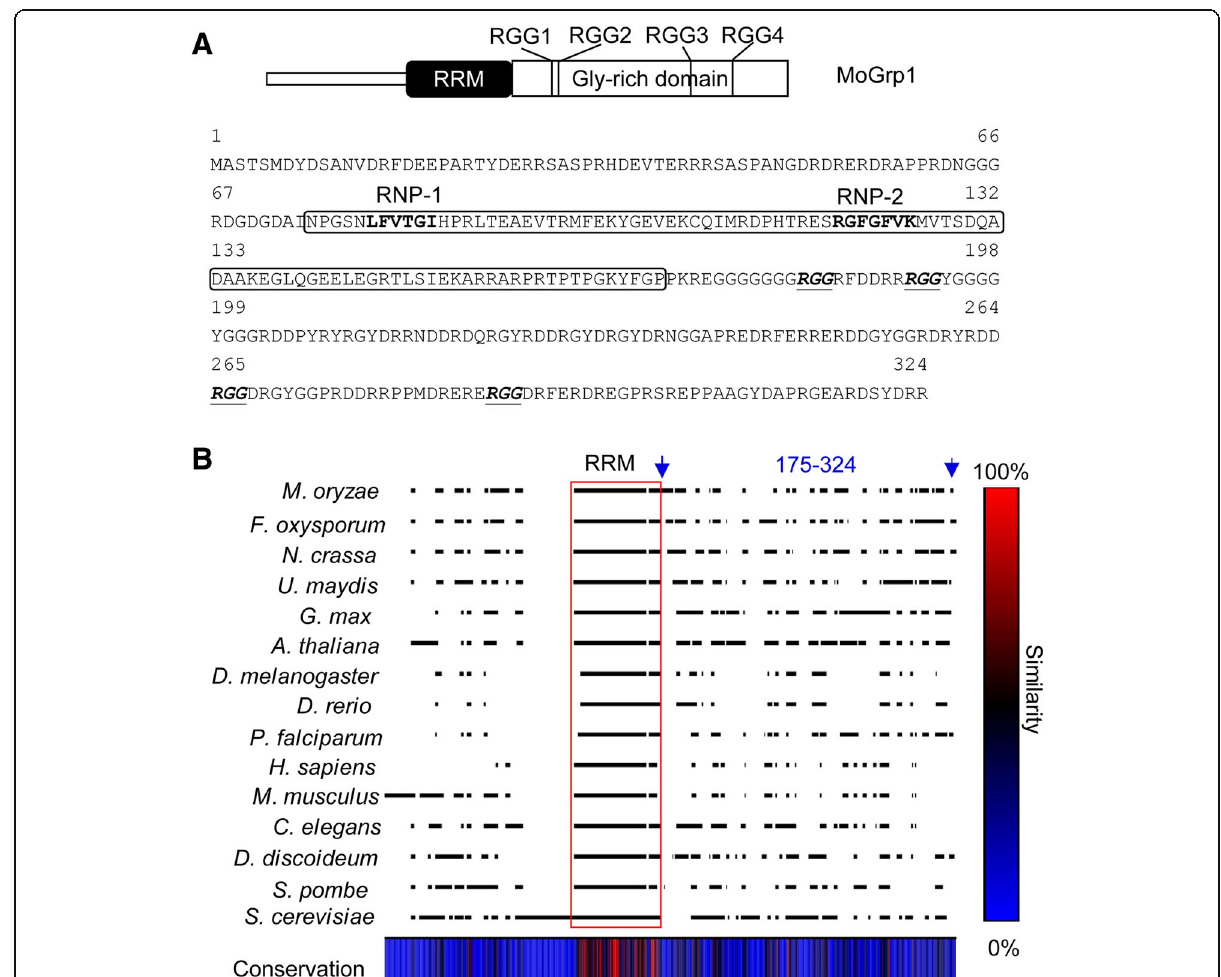
Fig. 1 MoGrp1 is a novel RNA-binding protein that is specific to filamentous fungi and contains a glycine-rich domain. a Domain organization and amino acid sequence of MoGrp1. RRM, RNA recognition motif; RGG, Arg-Gly-Gly motif; RNP-1 and RNP-2, two highly conserved sequences of RRM; b High divergence in the C-terminal of MoGrp1 and its orthologous proteins (Additional file 2: Figure S1). Red box marks the high similarity region; blue arrows point to the divergent region (174 to 324 aa in MoGrp1). Conservation is shown by gradient color: highest in red and lowest in blue. The alignment was built using the MAFFT program and sequences were visualized in CLC Sequence